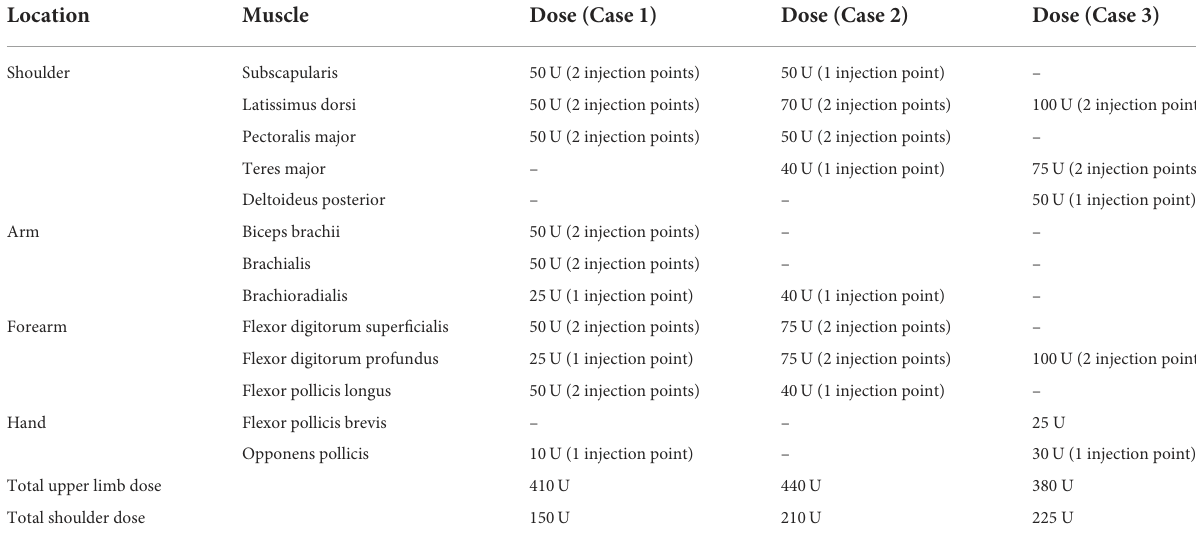
TABLE 3 IncobotulinumtoxinA injection schedule for each case report.